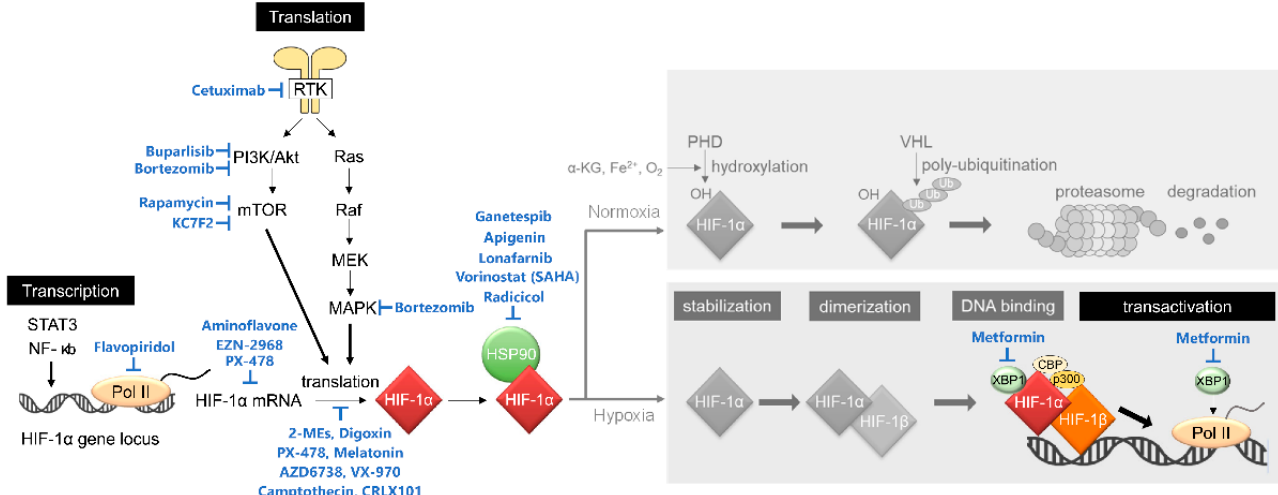
Figure 2. Non-canonical regulatory mechanisms behind the activation of HIF-1. HIF-1 activity is regulated at multiple steps, including transcriptional initiation of the HIF-1 α gene, translational initiation of HIF-1 α mRNA, stability of HIF-1 α protein, and transactivation of HIF-1 α . See the main text for details.